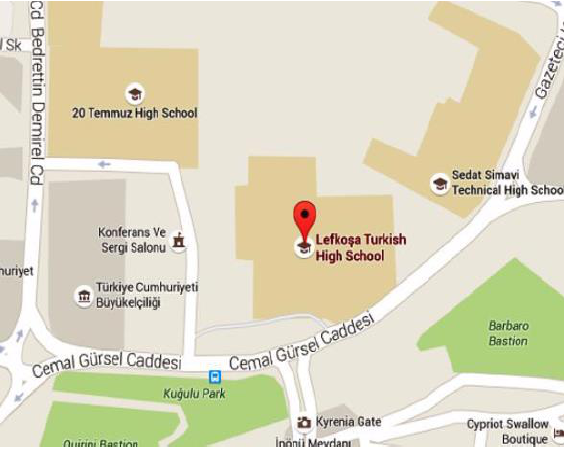
Figure 6. The location of the Lefkoşa türk lisesi, Source; Google map.